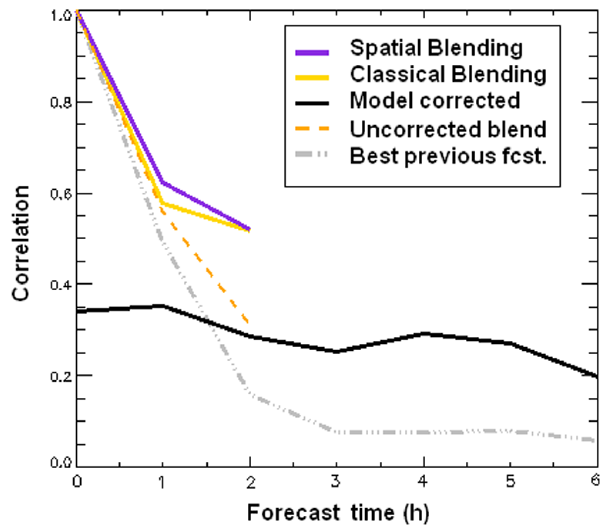
Fig. 7. Correlation of all the methodologies developed in the present work and the best previous one as function of forecast